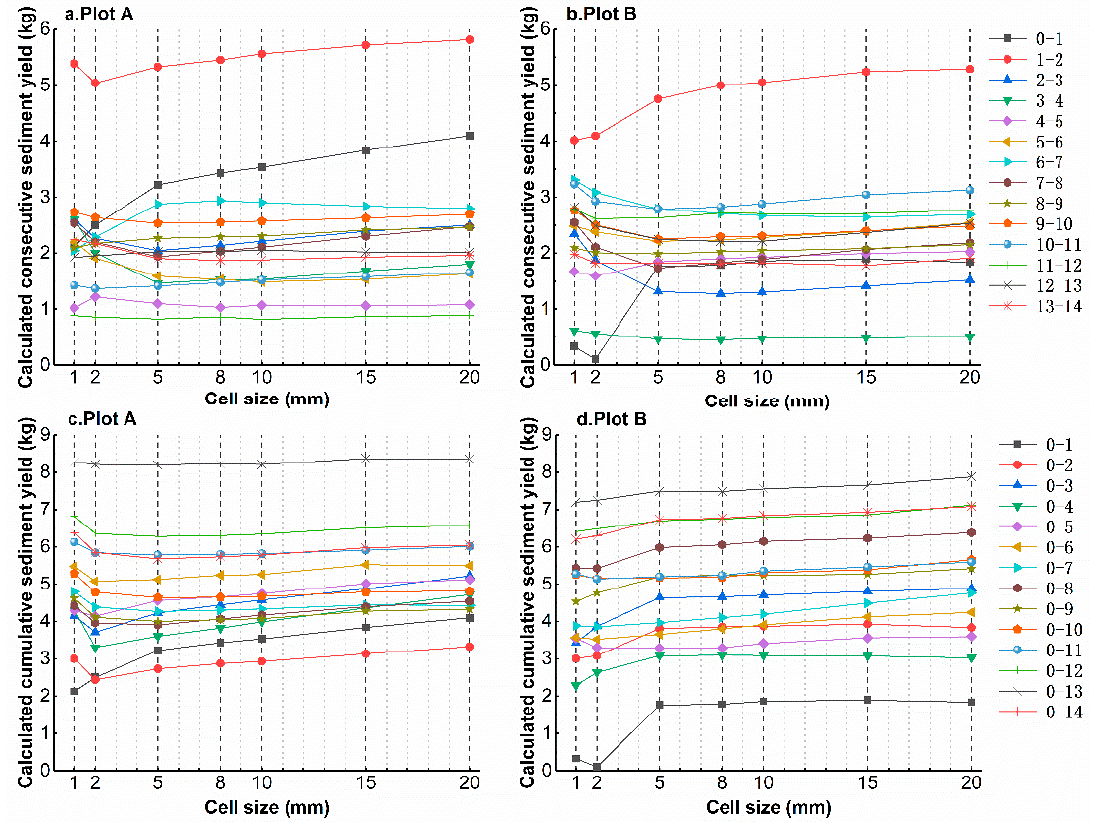
Figure 3. Changes of the sediment yield derived using terrestrial laser scanning (TLS) with grid-cell sizes: ( a , b ) changes of the calculated consecutive sediment yield for hillslopes of plots A and B; ( c , d ) changes of calculated cumulative sediment yield for hillslopes of plots A and B. The legend indicates the number of experiments, after which the TLS point clouds were employed to derive the sediment yield, for example, “0–1” indicates that the sediment yield was derived from the difference between the topography after the first experiment and the original topography.